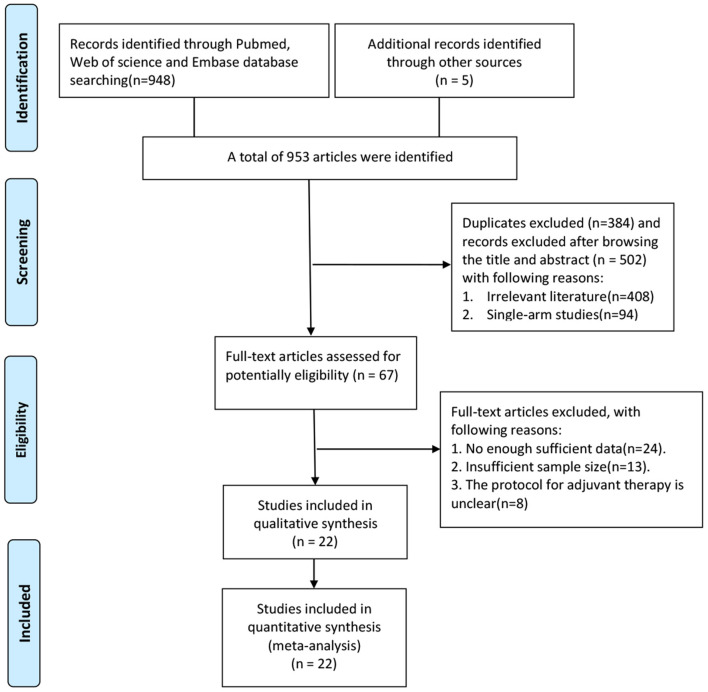
Flow chart of literature screening.